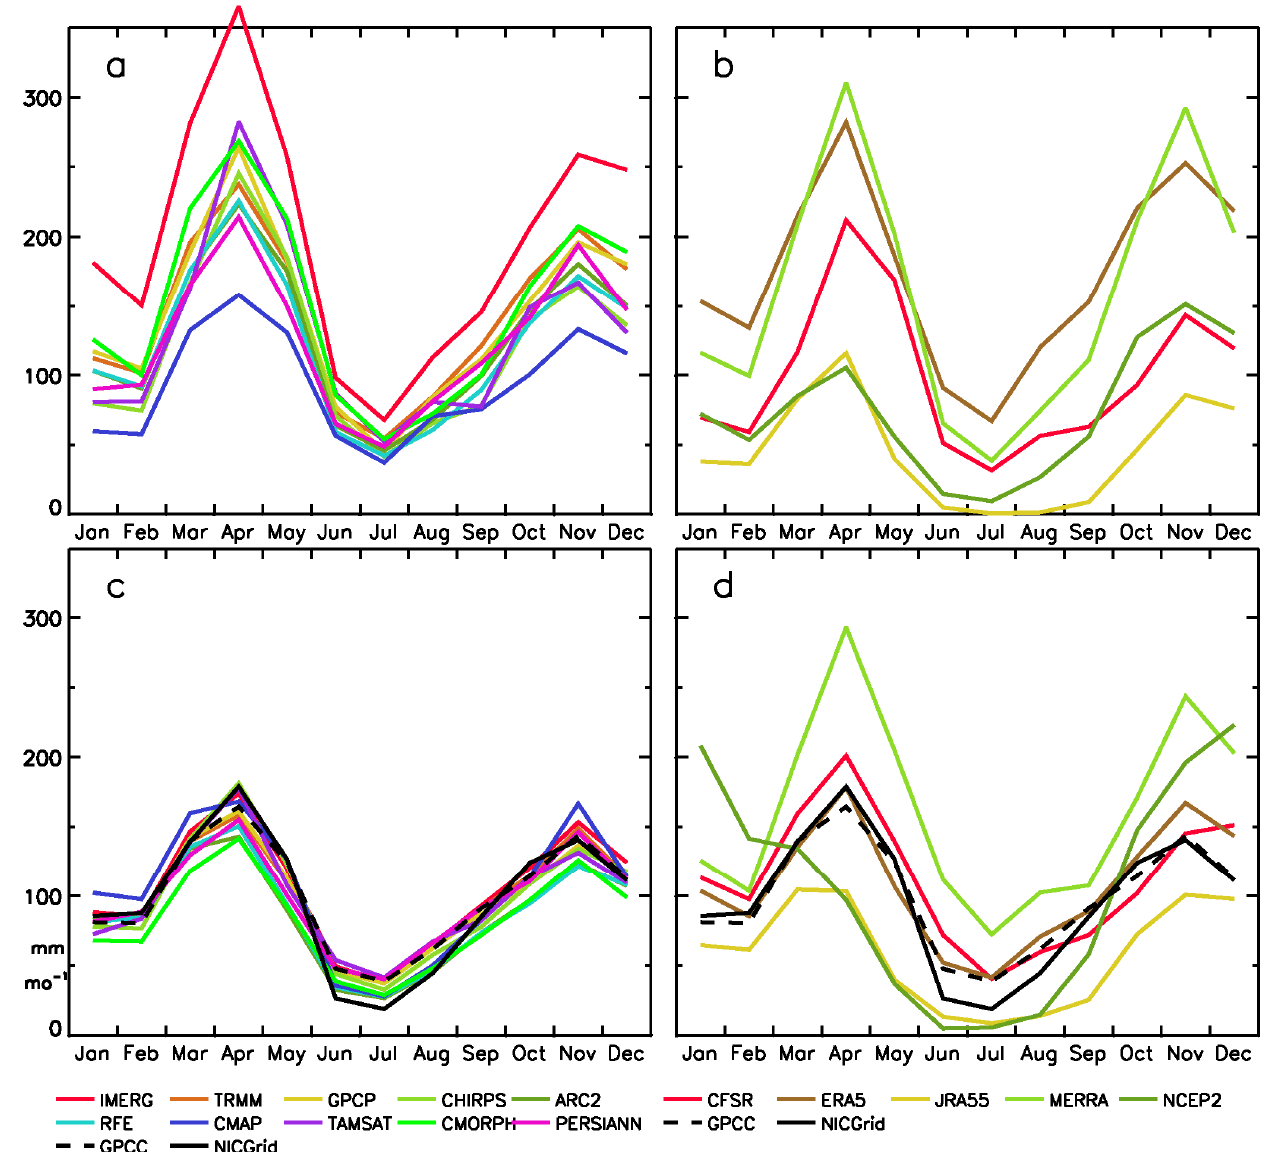
Figure 11. Seasonal cycle of rainfall (mm/mo) averaged over Lake Victoria or its catchment (see Figure 1 for location): NIC131 is an average for 1945–94, when gauge coverage was very dense. Others are averaged for 2001–2019: ( a ) Lake Victoria—satellite ( b ) Lake Victoria—reanalysis ( c ) Catchment—satellite ( d ) Catchment—reanalysis.